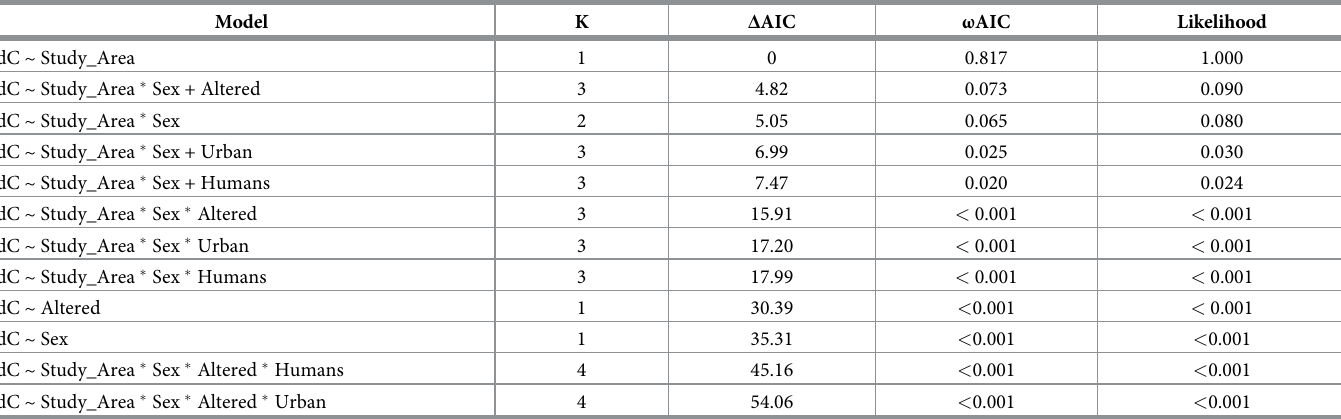
Table 3. AIC results for predicting carbon enrichment.